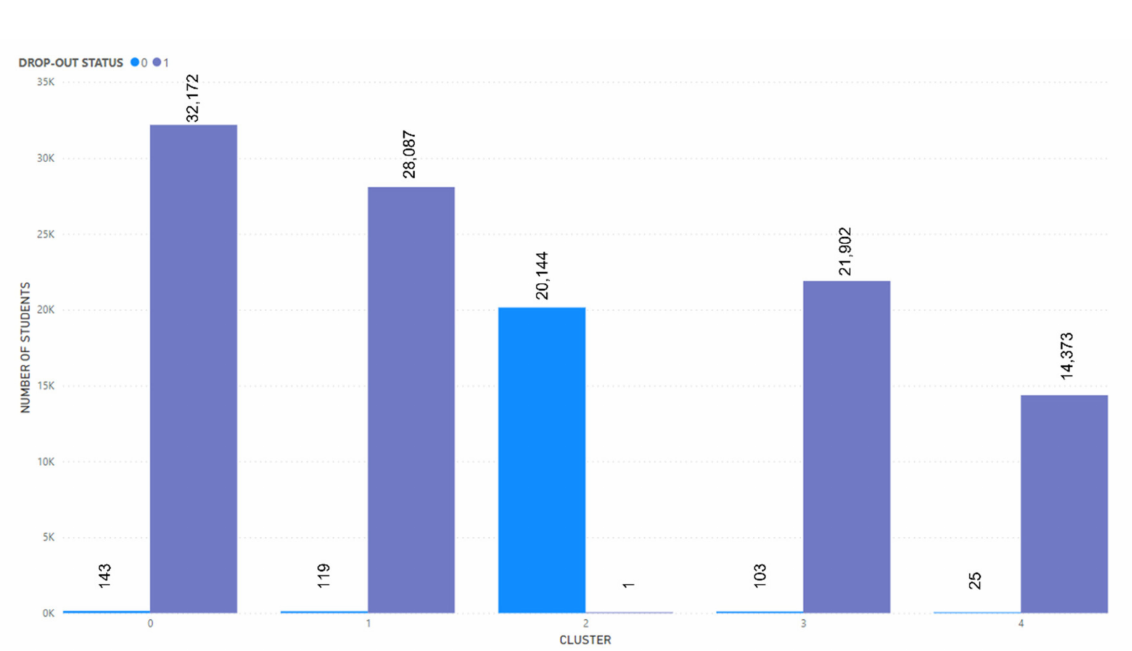
Figure 6. Clustering result of students’ drop-out status. The CGPA attribute with a value of 3.01–3.49 was a distinct characteristic for clusters 0, 1, 3, and 4, where the highest percentage of students (12.78%) is in cluster 0. Only cluster 2 has recorded a CGPA value of below 2.00 for 10.57% of students (refer to Figure 7). Working as a distinct value in clusters 0, 1, 3, and 4, with the highest percentage of students belonging to cluster 0. Cluster 2 comprises unemployed students who recorded a percentage of